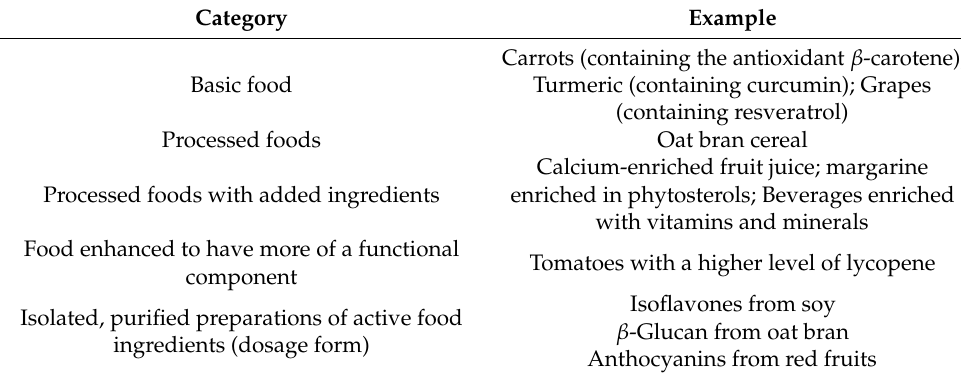
Table 5. Categories of functional foods. Category Example Carrots (containing the antioxidant β -carotene); Basic food Turmeric (containing curcumin); Grapes (containing resveratrol) Processed foods Oat bran cereal Calcium-enriched fruit juice; margarine Processed foods with added ingredients enriched in phytosterols; Beverages enriched with vitamins and minerals Food enhanced to have more of a functional Tomatoes with a higher level of lycopene component Isoflavones from soy Isolated, purified preparations of active food β -Glucan from oat bran ingredients (dosage form) Anthocyanins from red